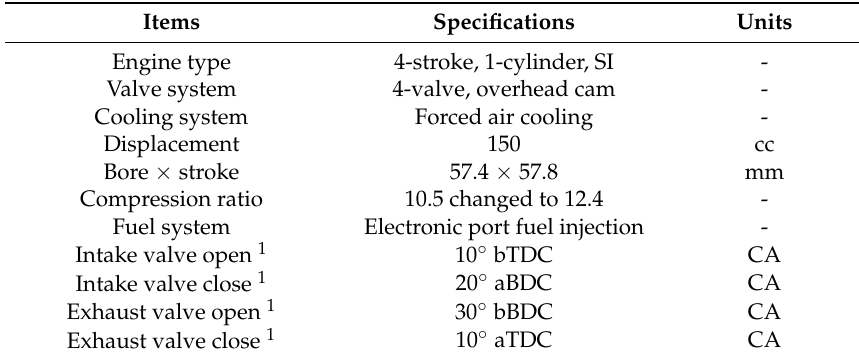
Table 2. Engine specifications.